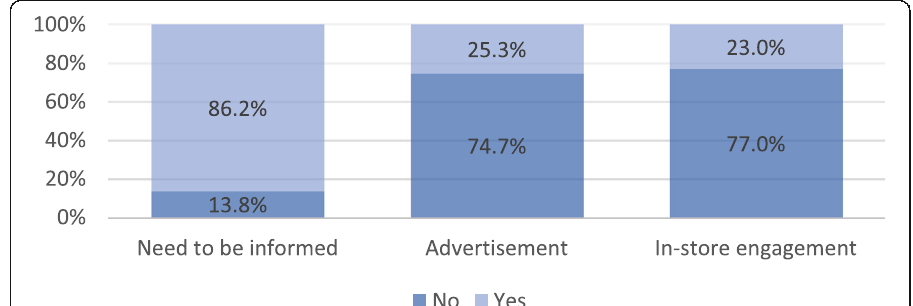
Fig. 11 The percentage of survey managers ’ opinions regarding customers ’ reaction to the DR activities in stores. N =